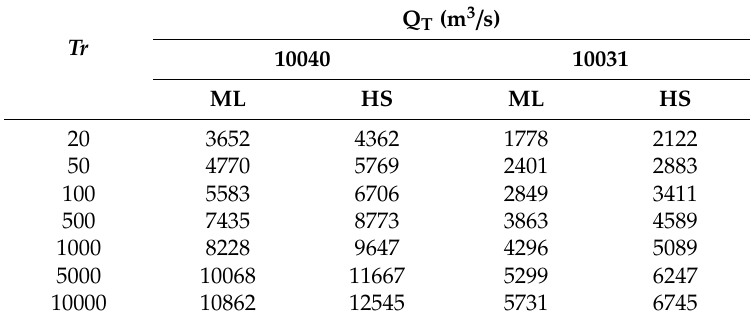
Table 5. Comparison of the design values of gaging stations 10040 and 10031 obtained by using the parameters computed in the EV1-3P by using ML and HS methods.